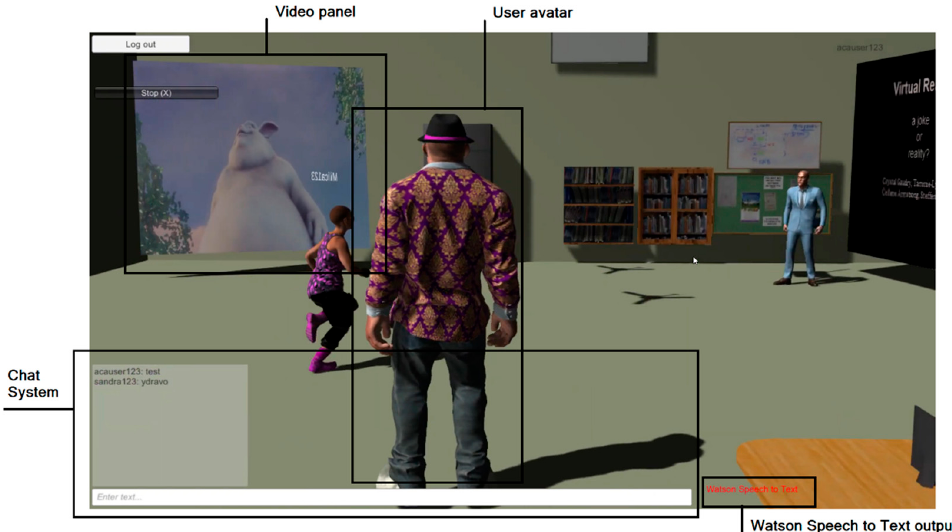
Figure 7. VoRtex virtual environment (Windows desktop, third-person perspective).